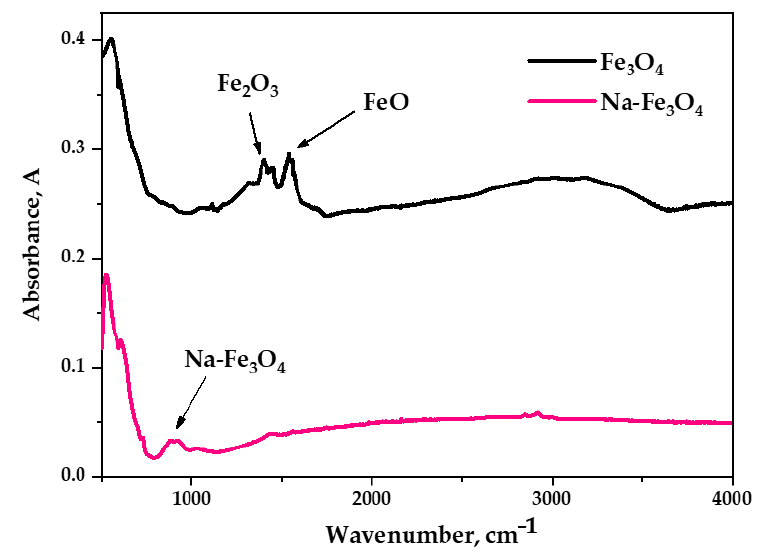
Figure 1. The FT-IR spectra of magnetite and Na-Fe 3 O 4 .